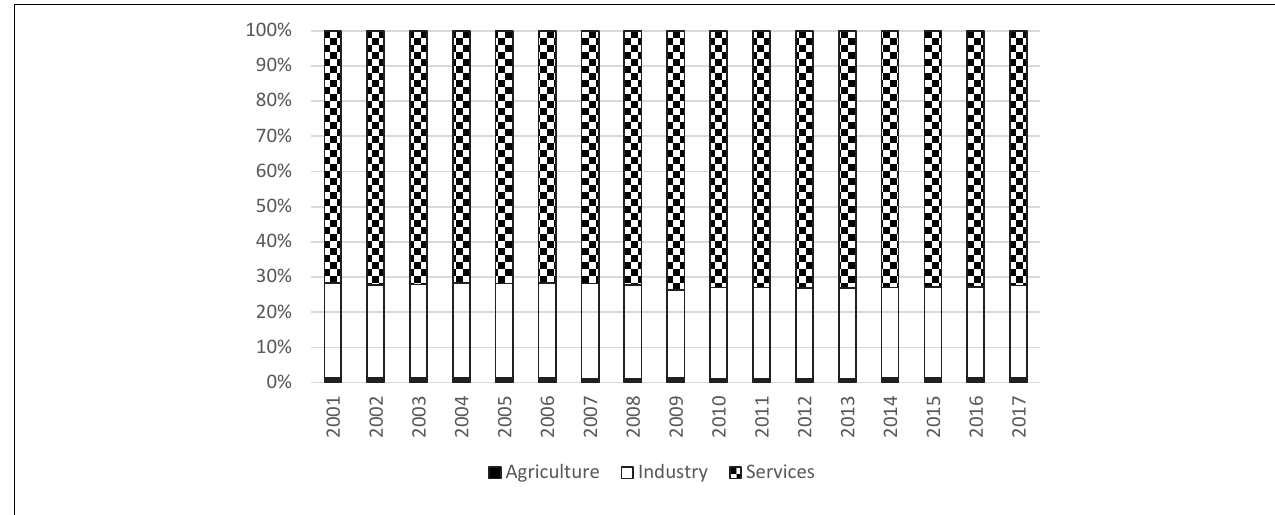
FIGURE 2 | Decomposition of inequality for the world, 2001 to 2017. Source: Authors’ calculation.